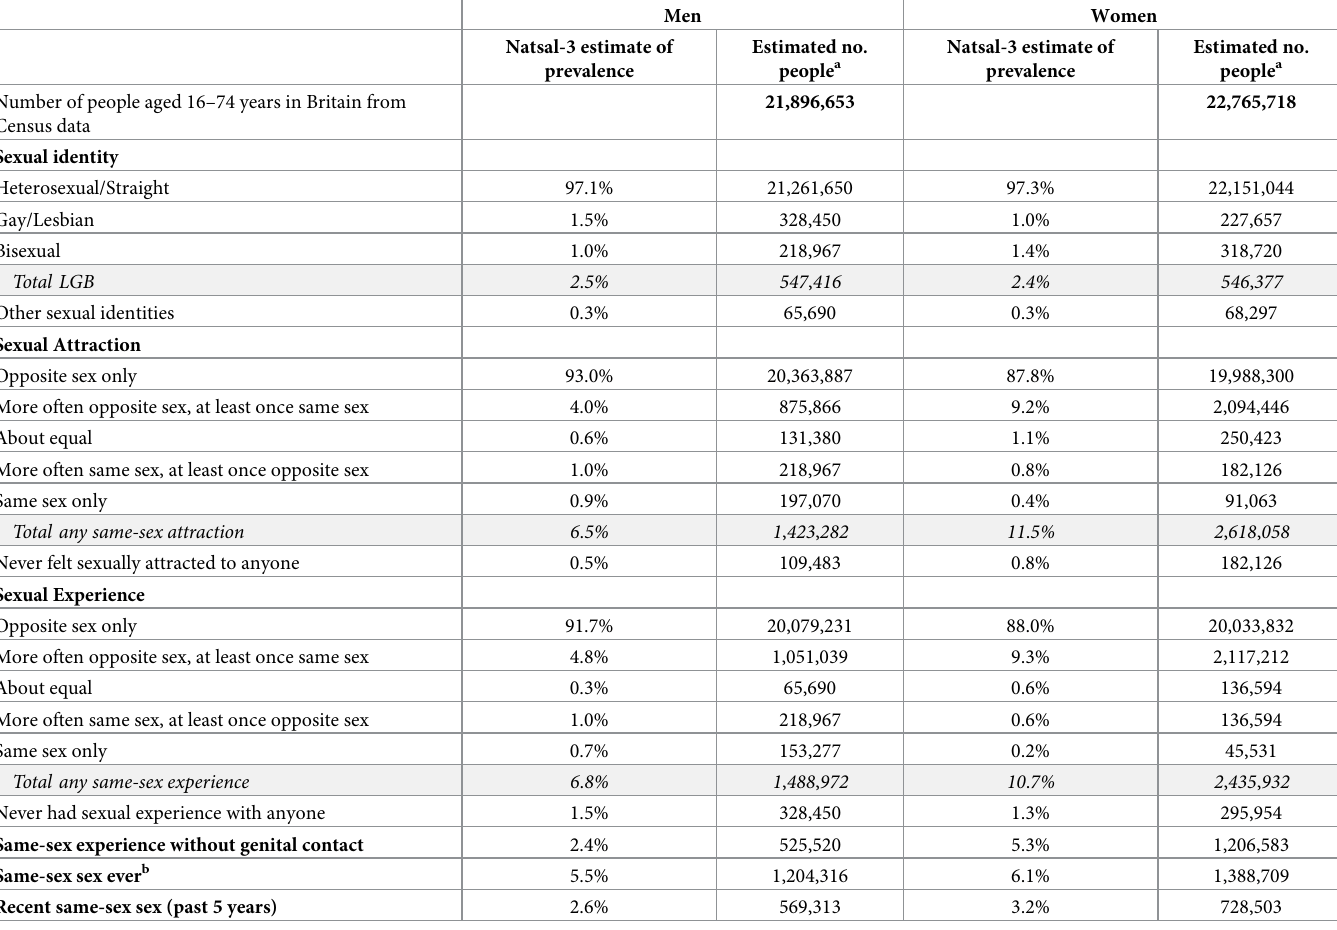
Table 3. Estimates of size of sexual minority populations in Britain for men and women aged 16–74 years.